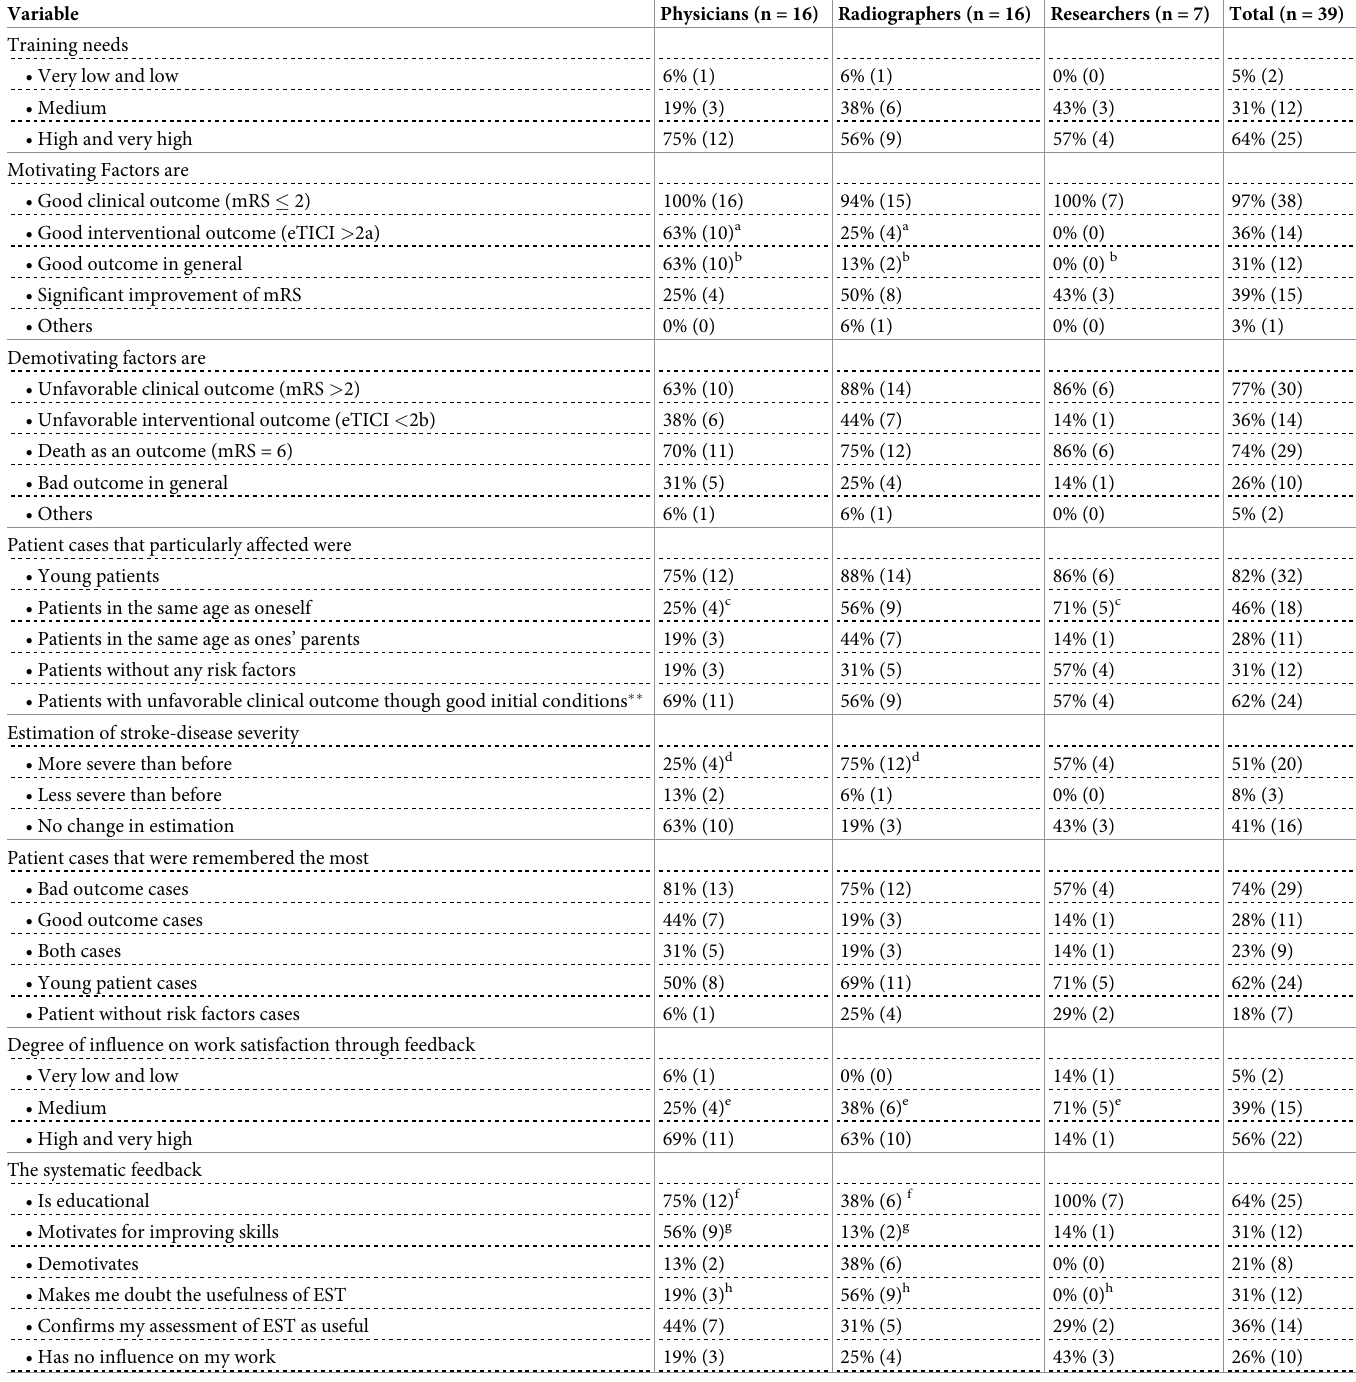
Table 2. Frequency of questionnaire variables in July, separated by profession and in total, in % � (actual numbers reported in brackets).